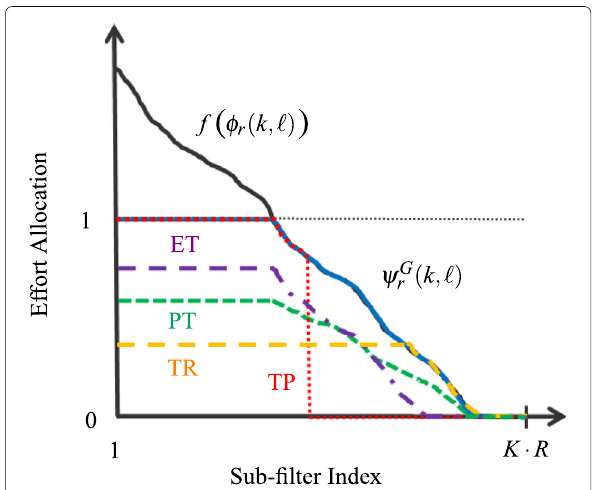
Fig. 3 Exemplary function f plotted in sorted order of highest to lowest values, along with different criteria for modifying ψ G r ( k , (cid:2)) in case M G ((cid:2)) > Q · K ·